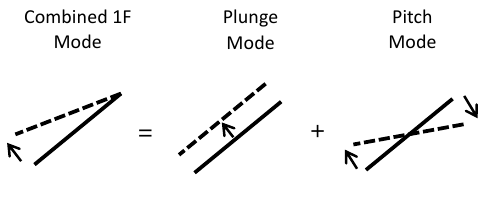
Figure 1. The 1F mode shape as the superposition of plunge and pitch